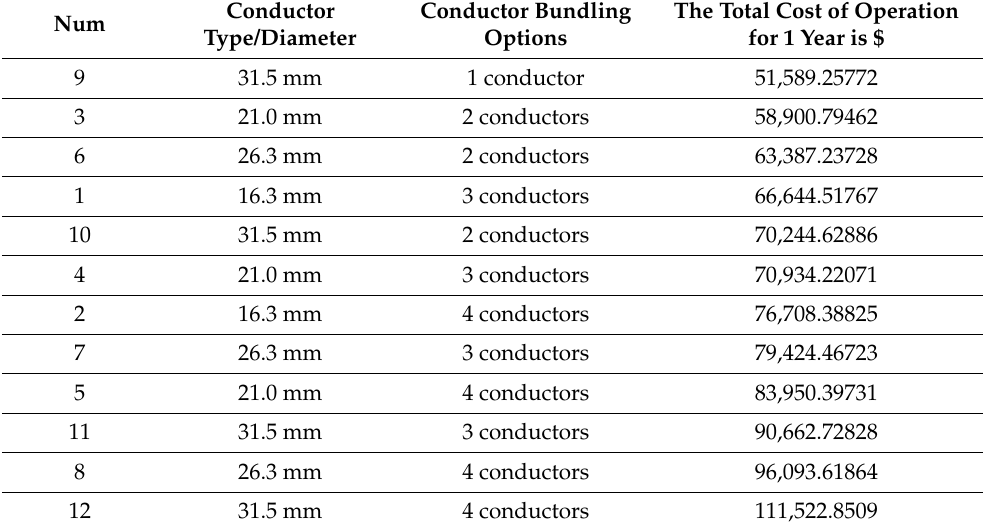
Table 4. Comparison of the total cost of 12 types of lines in one year of operation.